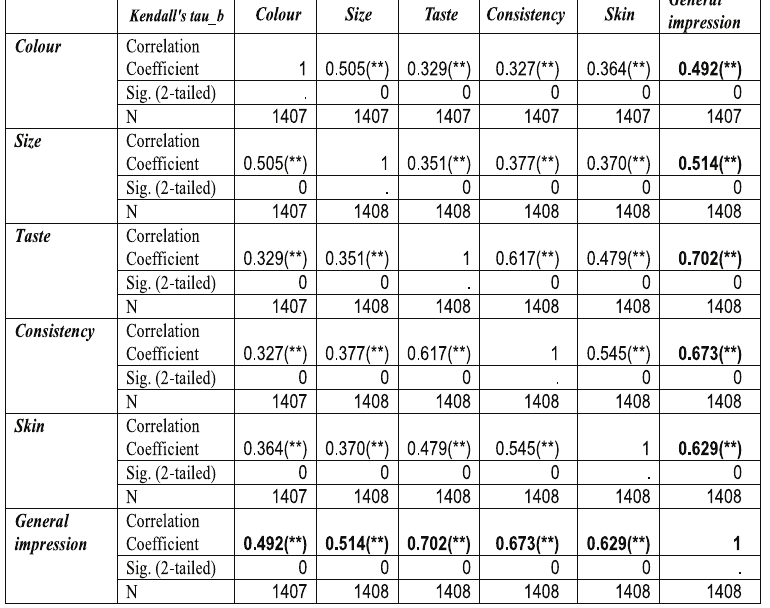
Table 1: Relation between the scores of individual characters and of general